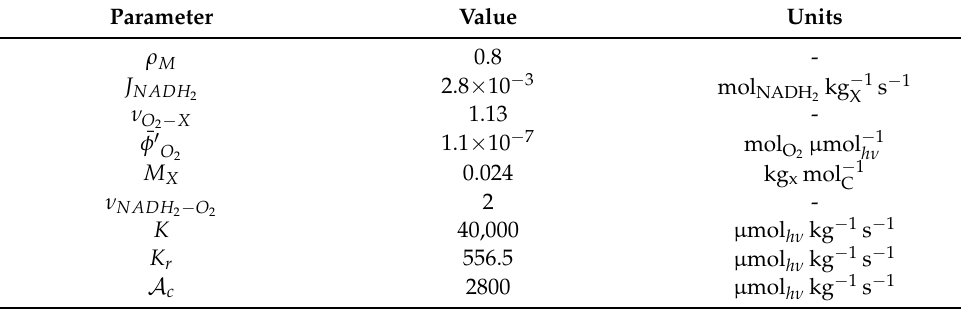
Table A1. Kinetic growth parameters of Chlorella vulgaris from Ref.